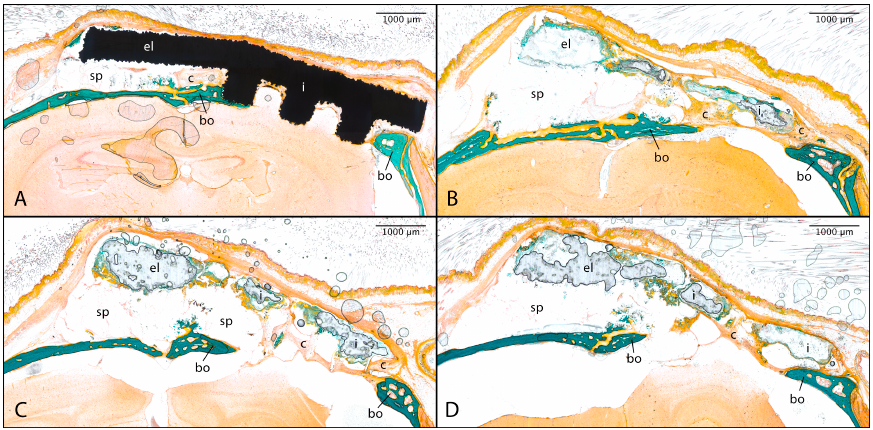
Figure 15. Representative histological images of the implant bone contact after 84 days for mice treated with either uncoated Ti6Al4V implants ( A ) or PCL-coated magnesium implants without previtalisation ( B ) or previtalised with murine osteoblasts ( C ) or mADMSCs ( D ). The magnesium implants appear to be dissolved after trichrome-masson-goldner staining (bo = bone tissue, c = connective tissue, el = elongated fixation strut, i = implant, sp = free space; scale bar = 1000 µ